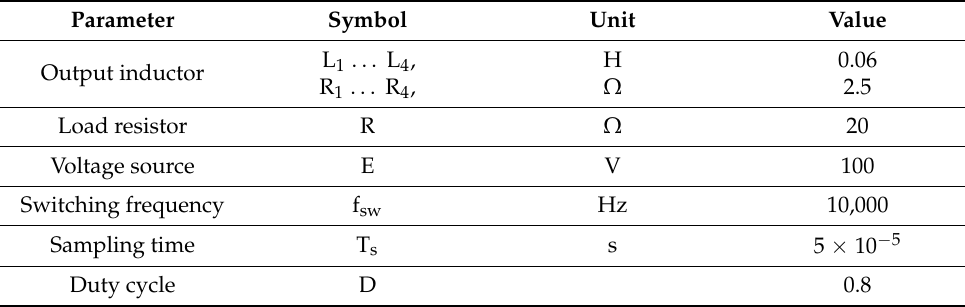
Table 9. Parameters of four-phase converter with algorithm DSA-PSC.